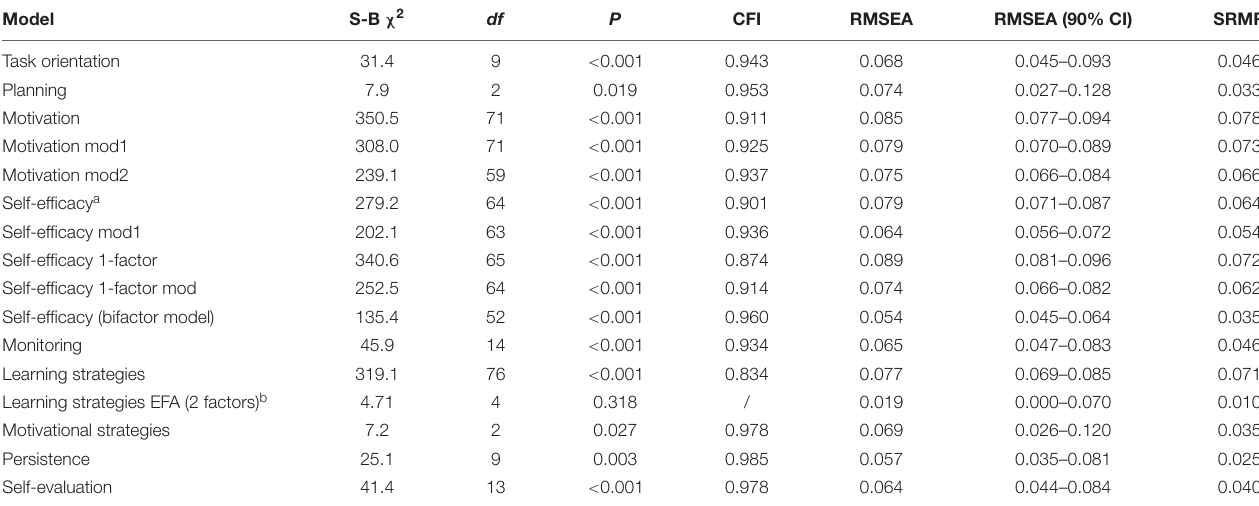
TABLE 3 | Fit indices for the CP-SRLI